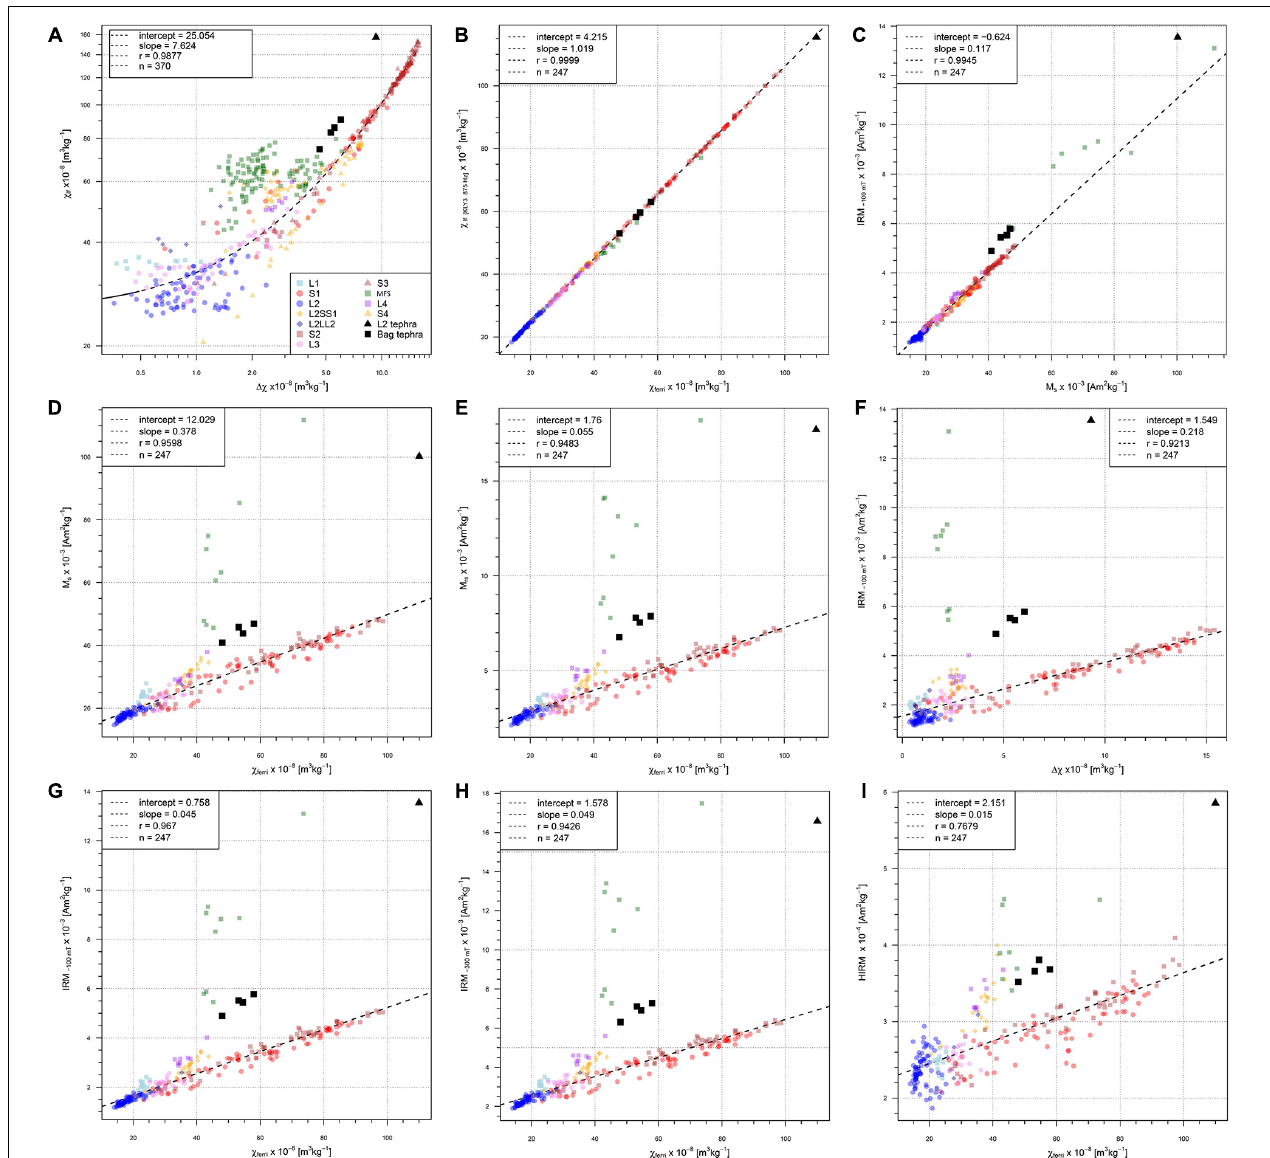
FIGURE 5 | Scatterplots of environmental magnetic data. Low frequency susceptibility ( χ lf ) plotted against (cid:49) χ in (A) shows the characteristics of magnetic enhancement for the Zemun LPS. Samples stemming from the MFS (marshy floodplain sediments) and the tephra layers are excluded for calculated regression fit and correlation coefficient, resulting in 370 samples out of a total of 479 for (A) and 247 samples out of a total of 262 for (B–I) .